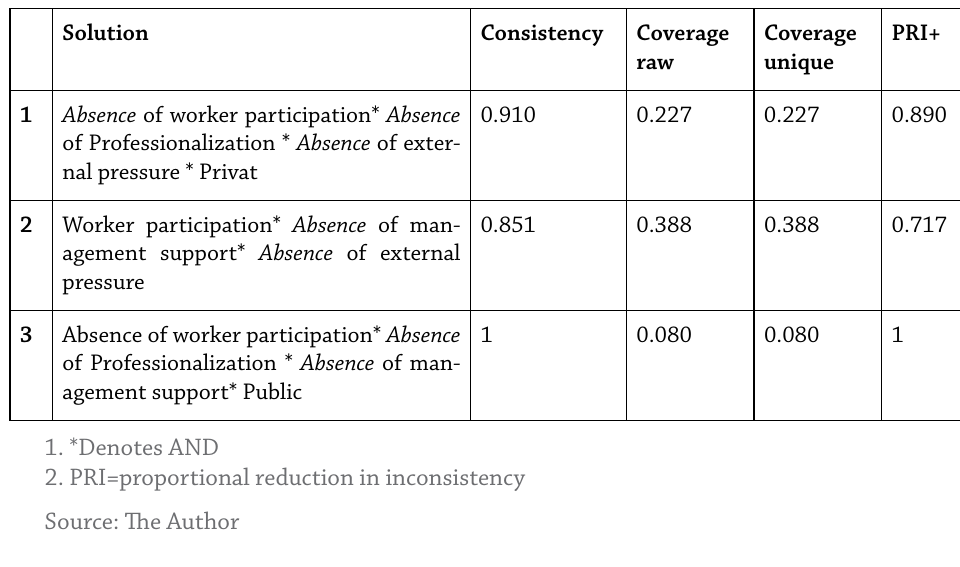
Table 10: Solutions explaining